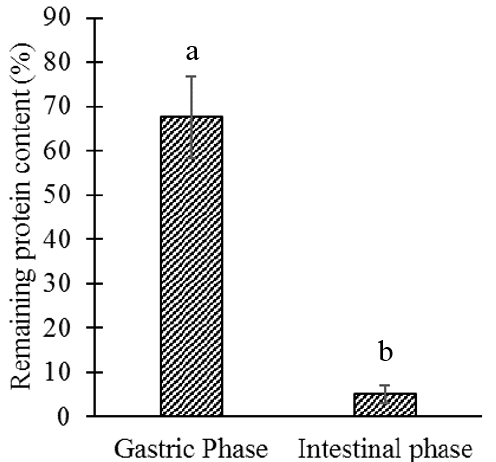
Figure 6. The remaining protein content after exposing microparticles to simulated fish gastrointes- tinal conditions. Microparticles were evaluated in an in vitro two-stage assay: (i) Gastric phase: acidic dissolution medium (KPH/HCl, pH 3.0) for 15 min. (ii) Intestinal phase: alkaline medium (phosphate buffer pH 8.0) for 60 min. Different lowercase letters indicate significant differences ( p ≤ 0.05) of the remaining protein content (%) among the different phases of digestion.